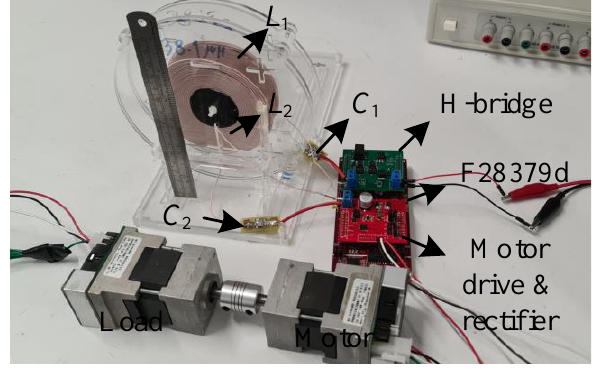
Figure 13. Experimental setup.